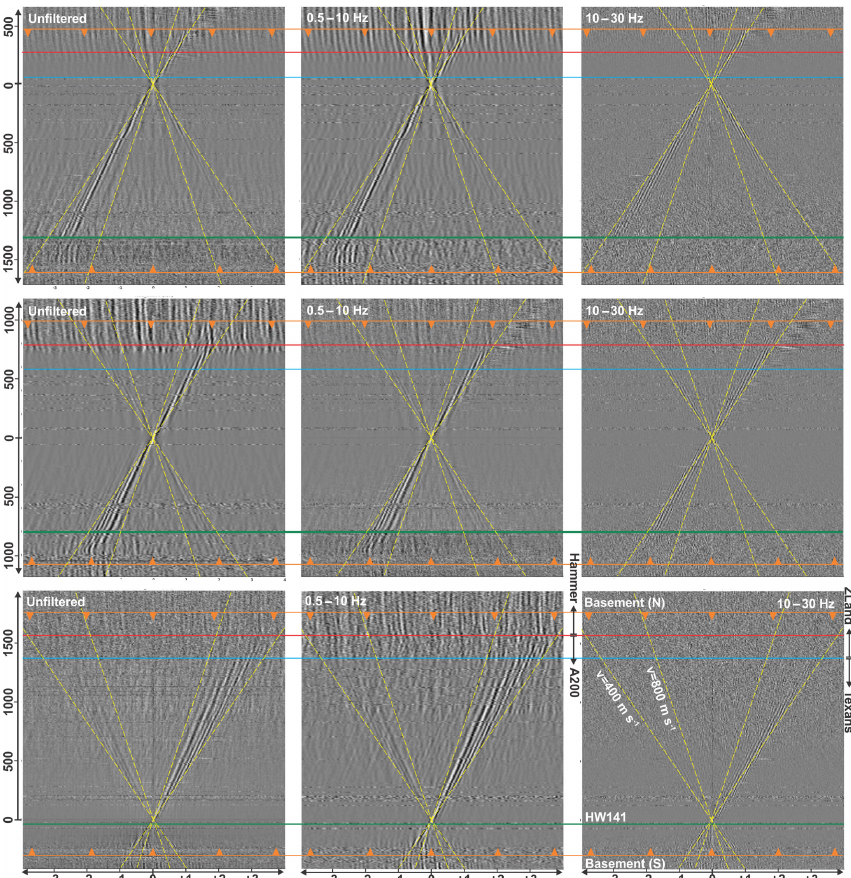
Figure 6. Three virtual source gathers in three different frequency bands. Traces are arranged horizontally from north (top) to south (bottom). Vertical axis: virtual source–receiver offset. The blue line discriminates ZLand 3C nodes (north) from Texan 1C geophones (south). The red line discriminates the area with hammer shots (north) from the area with A200 blasts (south). Green line: highway 141. Yellow lines: move- outs for velocities of 400 and 800ms − 1